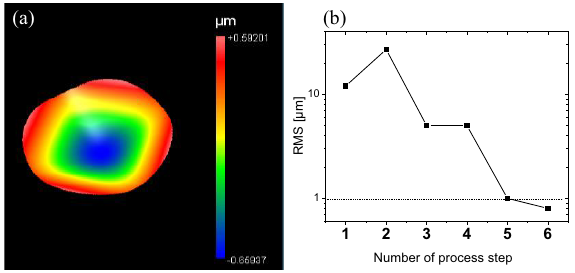
Fig. 4. (a) Freeform target design, (b) process convergence in terms of residual error